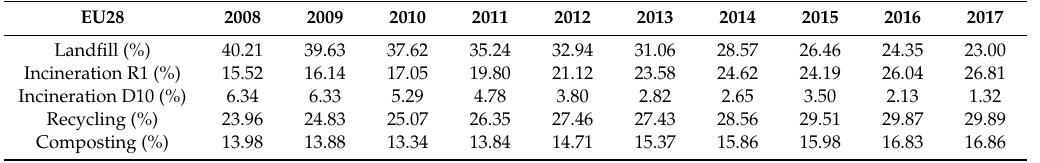
Table 2. Municipal Solid Waste (MSW) treatment methods in EU28 for